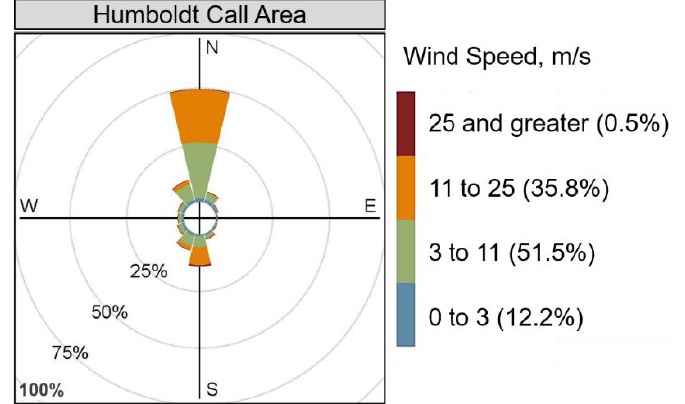
Figure 6. Annual wind rose for the Humboldt Call Area. Percentages on the radial axis represent the percent of time the wind velocity occurred.